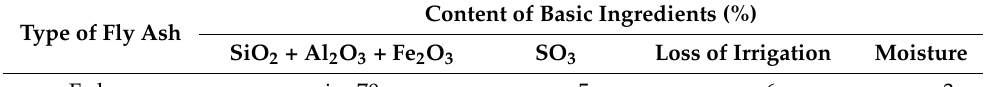
Table 1. Requirements for the chemical composition of class F ash [30].